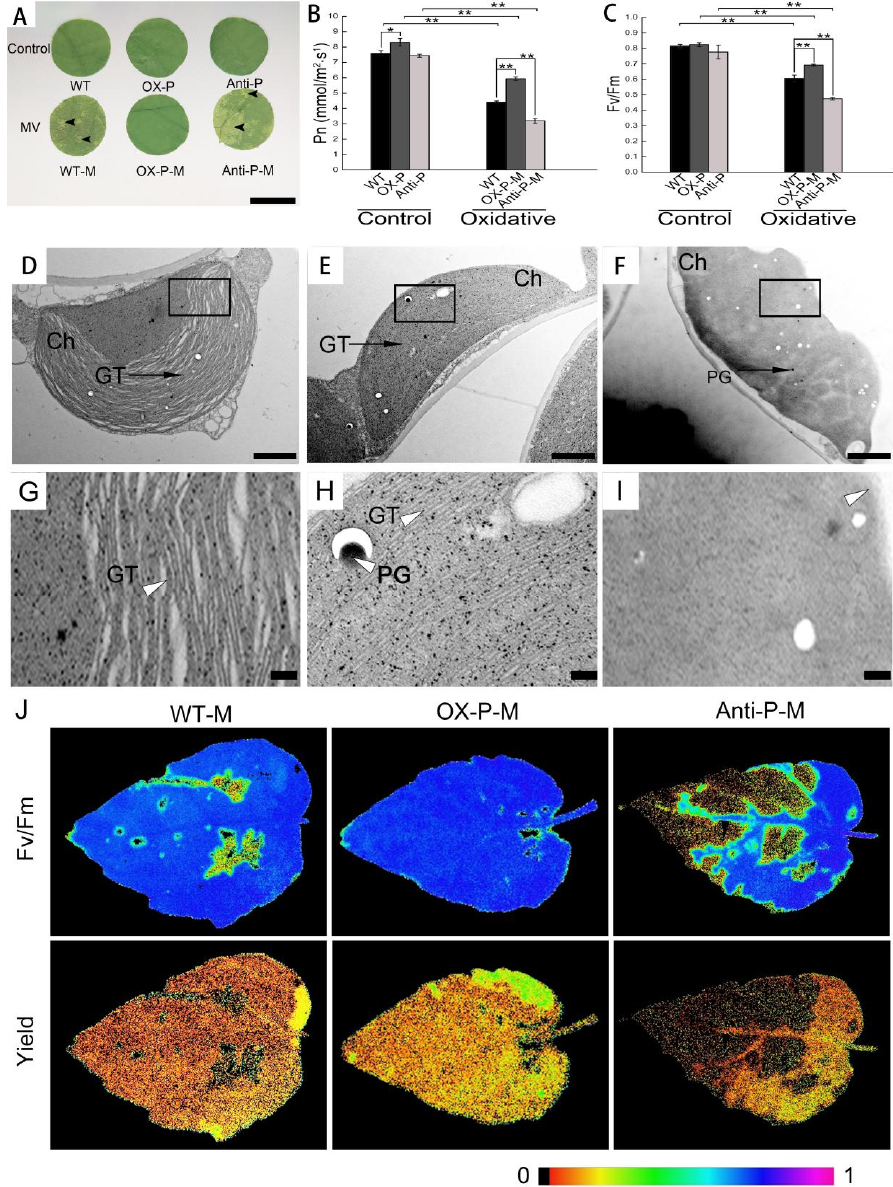
Figure 3. The change in chloroplast oxidant contents and subcellular structure in transgenic P. tomentosa under oxidative conditions. ( A ), The change in wild-type and transgenic leaves treated with 100 µ M MV for 5 h. WT-P-M, WT treated with MV; OX-P-M, OX-P treated with MV; anti-P-M, anti-P treated with MV. Bar = 0.5 cm. Black arrow-heads in ( A ) marked the transparent spots in transgenic plants treated with methyl viologen (MV). ( B ), Measurement of Pn under 100 µ M MV for 24 h. ( C ), Fv/Fm under 100 µ M MV for 24 h. ( D – I ), Ultrastructural images of chloroplast in leaves under MV oxidative condition. ( D ) and ( G ), WT-M; ( E ) and ( H ), OX-P-M; ( F ) and ( I ), anti-P-M. GT, grana thylakoid; Ch, chloroplast; PG, plastoglobule. Bar = 1 µ m. In ( D – I ), white arrow-heads marked the partial enlarged views of thylakoids or blurry chloroplast membrane under oxidative conditions in WT-M, OX-P m and anti-P-M, respectively. ( J ), PSII quantum yield of PSII and maximum efficiency of PSII (Fv/Fm) treated with 100 µ M MV for 24 h. The false color scale is given on the bottom. The false color means the spatial distribution of Fv/Fm and yield values ranging from black (0.0) to purple (1.0). All values are means ± SD ( n = 3). Significant differences between mean values are indicated by asterisks using Student’s t -test. ** and * indicate p < 0.01 and p < 0.05,